Question: Express in one sentence what the figure is showing.
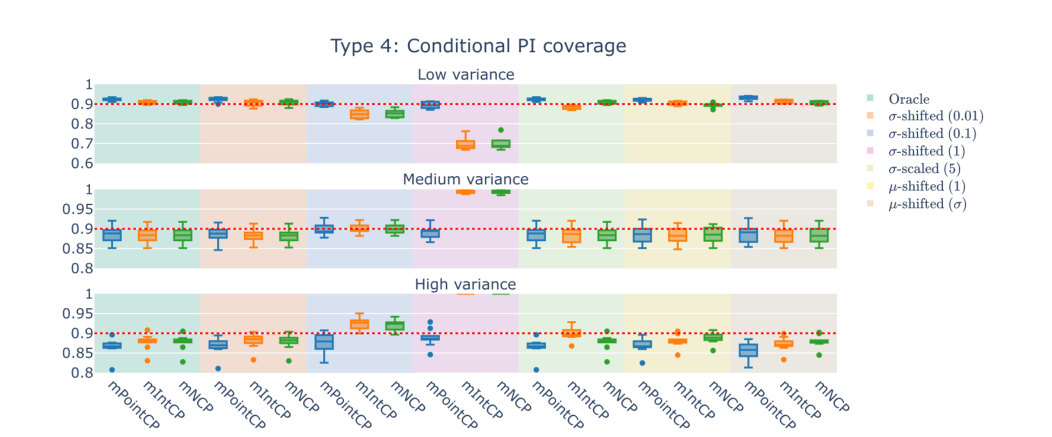
Answer: Conditional coverage at significance level α = 0.1 for a synthetic data set of Type 4. The data is divided in three folds based on equal-frequency binning of the estimated variance. The coloured columns indicate the type of misspecification (from left to right): oracle, additive noise for the standard deviation (means of 0.01, 0.1 and 1), scaling by factor 5 of the standard deviation and additive noise for the mean (means of 1 and bσ). For every model, three nonconformity measures are shown (from left to right): residual, interval and bσ-normalized nonconformity measure.